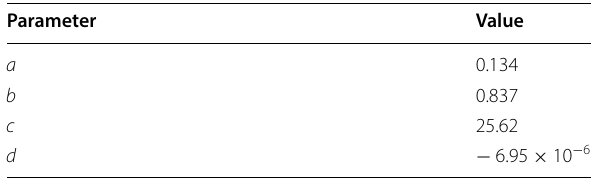
Table 1 Explanation of regression parameters of Eq. (1) Parameter Description